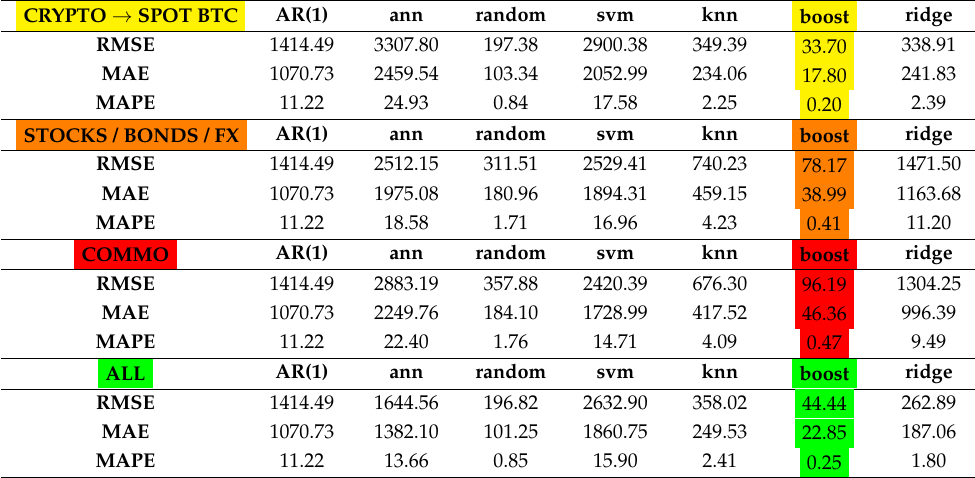
Table 12. Sub-sample forecasting results of Coinbase Bitcoin Spot price during the year 2020.